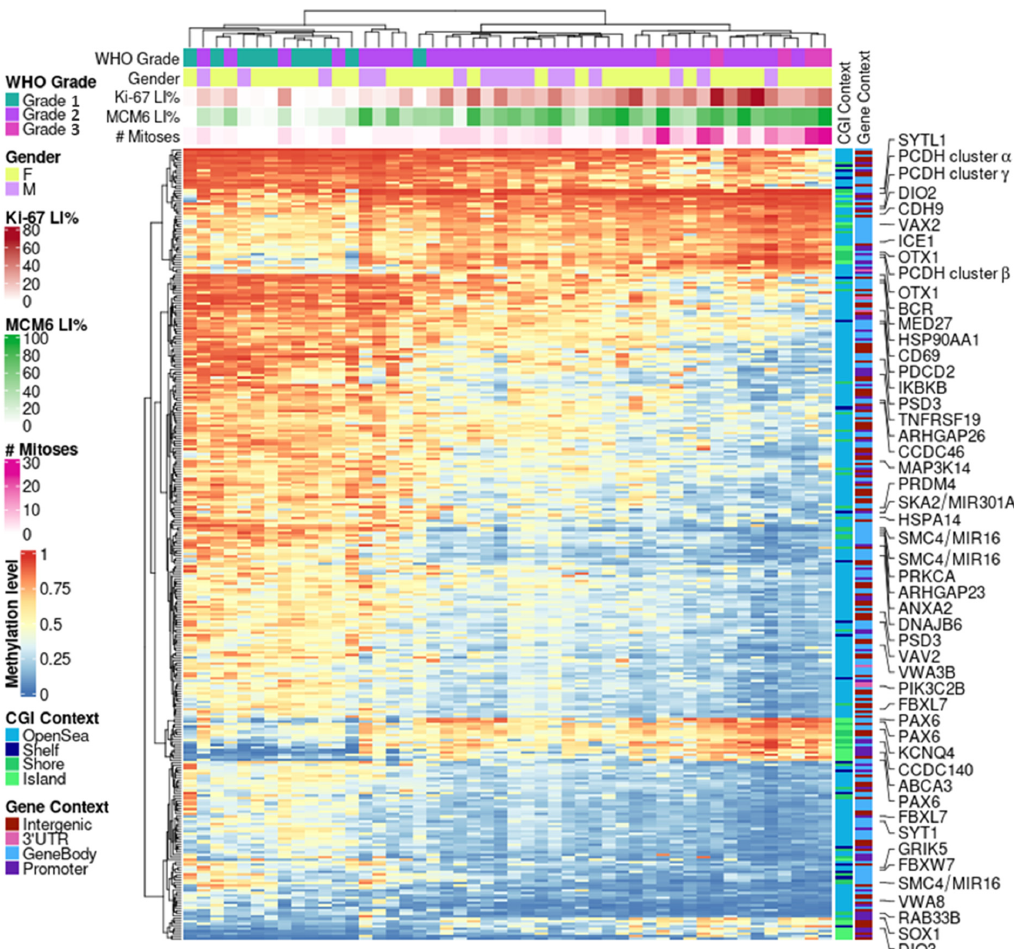
Figure 4. DNAm proliferation signature in meningiomas . Hierarchical clustering heat map depict- ing 310 CpGs highly correlated between DNAm and three proliferative markers: mitotic index, Ki-67, and MCM6 expressions (metrics: Euclidean distance and complete linkage). CGI: CpG island; DNAm: DNA methylation; LI: labeling index; WHO: World Health Organization.